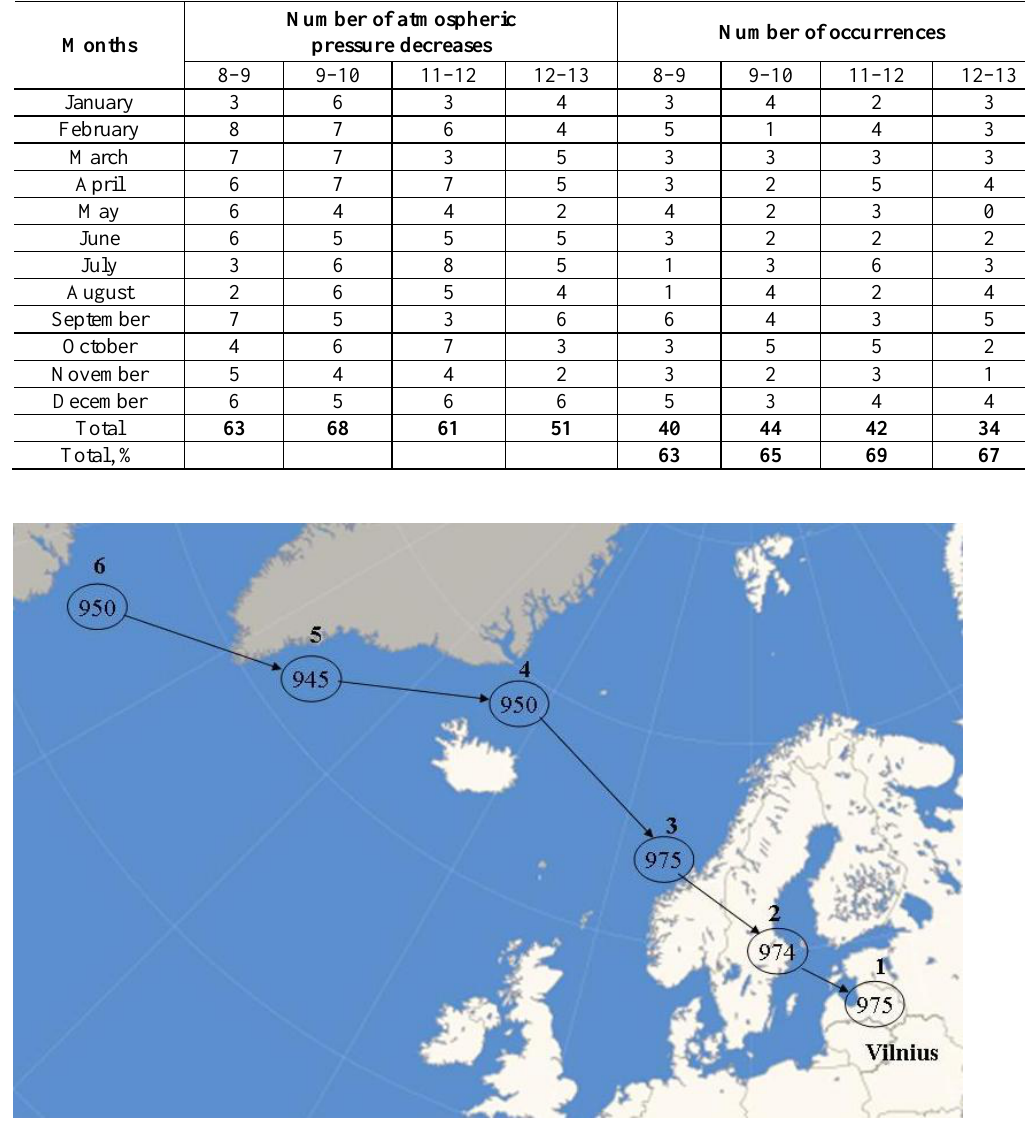
Fig. 2. Cyclone transfer from Newfoundland towards Vilnius city. Number in circles is atmospheric